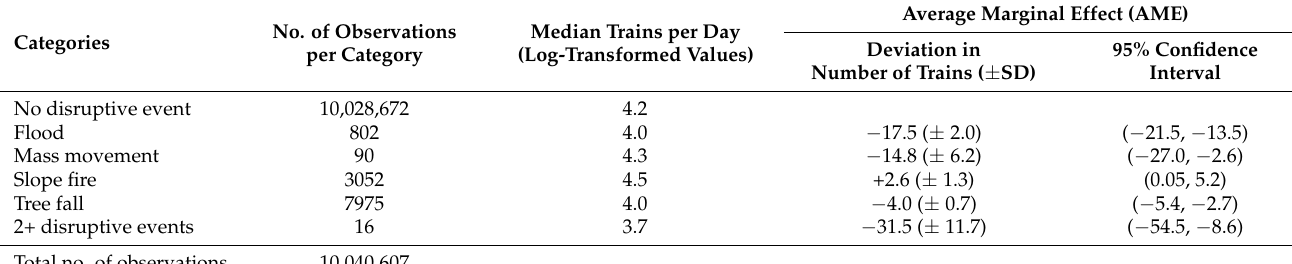
Table 3. Descriptive statistics and results from the regression analysis.